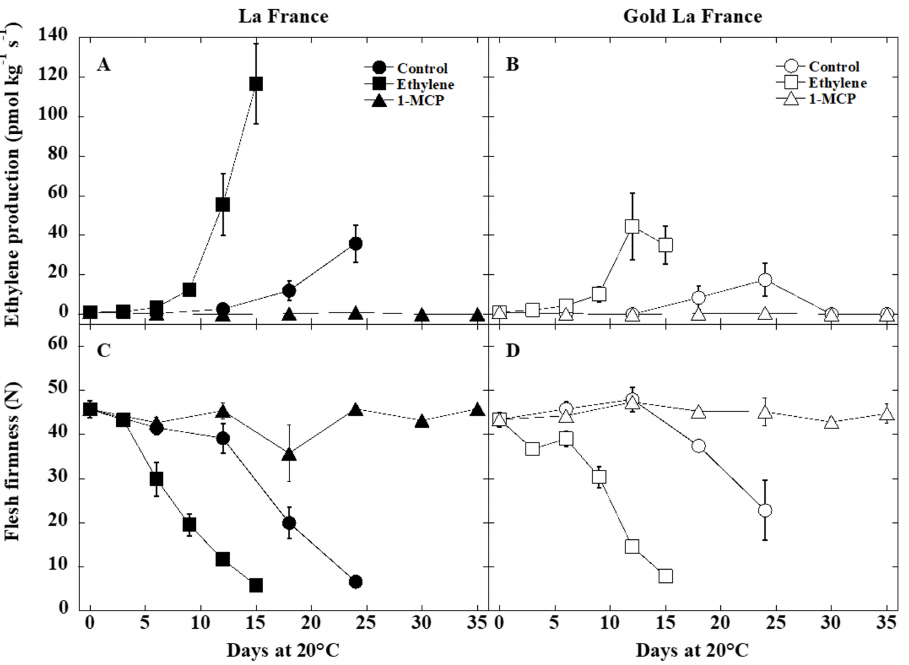
Figure 2. Changes in the ethylene production ( A , B ) and flesh firmness ( C , D ) of ‘LaFrance’ and ‘Gold La France’ fruit treated with ethylene and 1-MCP during ripening at 20 ◦ C. Values are means ± standard errors ( n =